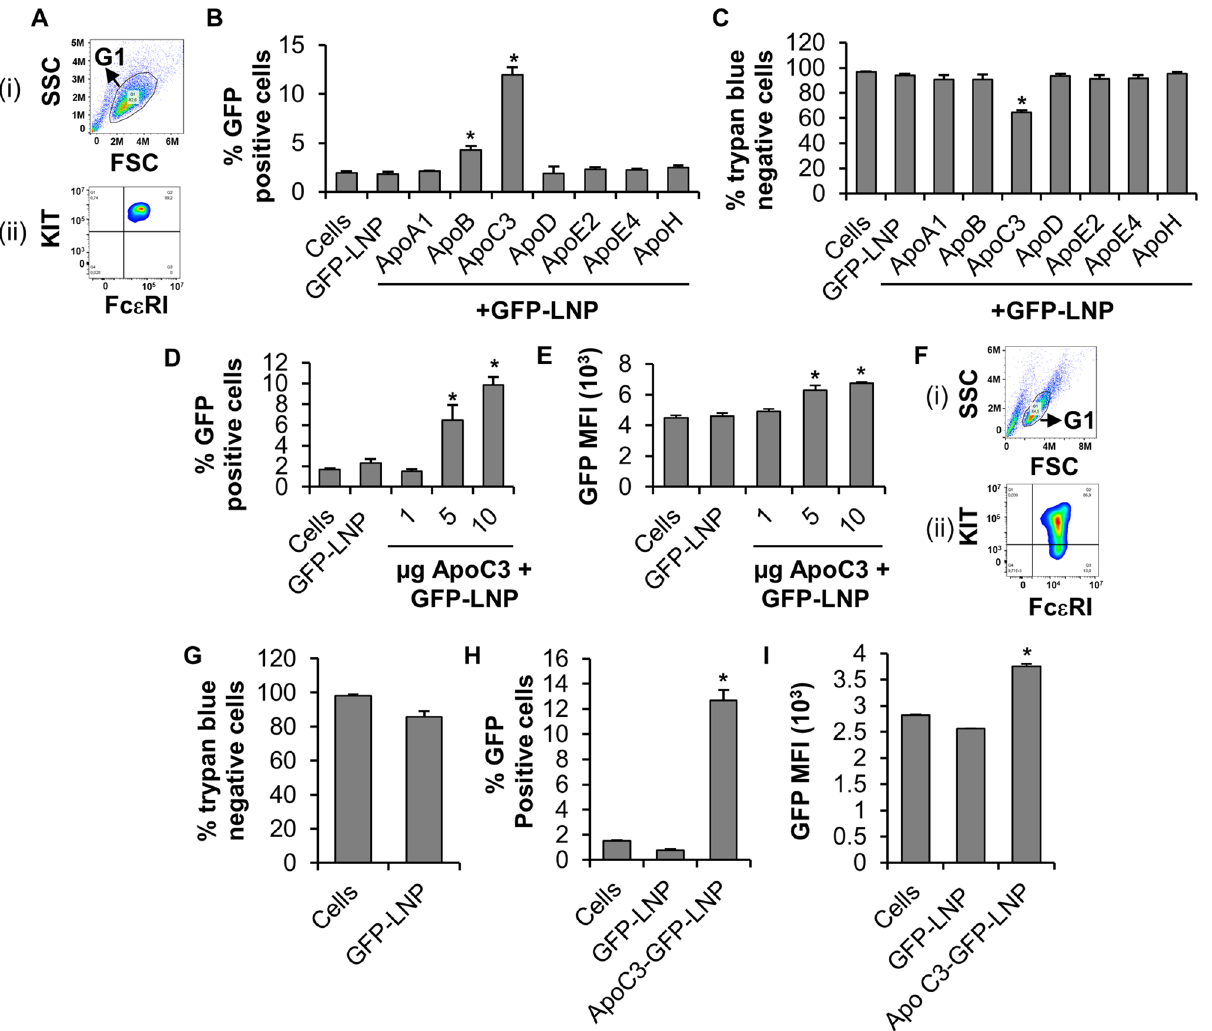
Figure 2. ApoC3 facilitates internalization of GFP-DODMA-LNP (GFP-LNPs) into BMMC and MC/9. ( A ) Gating strategy used to exclude debris/dead cells from flow cytometric analysis of terminally differentiated BMMC co-expressing FcεRI and KIT receptors. ( B , C ) BMMC were treated with 3 µg Apo (ApoA1, B, C3, D, E2, E4 and H)-GFP-LNP’s or GFP-LNP alone followed by flow cytometry ( B ) or trypan blue staining ( C ). Cells represent control BMMC that have not been treated with GFP-LNP or Apo-GFP-LNP. ( D , E ) BMMC were transfected for 24 h with ApoC3 (1–10 µg)-GFP-LNP’s followed by flow cytometry to determine % GFP positive cells ( D ) and GFP mean fluorescence intensity (MFI) ( E ). ( F ) Gating strategy used to exclude debris/dead cells from flow cytometric analysis of MC/9 co-expressing FcεRI and KIT receptors. ( G ) MC/9 were treated with GFP-LNP for 24 h followed by trypan blue staining. Cells represent control MC/9 that have not been treated with GFP-LNP. ( H , I ) MC/9 were transfected with 3 µg ApoC3-GFP-LNP followed by flow cytometry to determine % GFP positive cells ( H ) and GFP MFI ( I ). Cells represent control MC/9 that have not been treated with GFP-LNP or ApoC3-GFP-LNP. n = 3. p < 0.01 (*) is relative to positive cells with 5 and 10 µg of ApoC3 (Fig. 2D, p < 0.05; Supplementary Fig. 1A) and a concentration-depend- ent increase in GFP mean fluorescence intensity (MFI) (Fig. 2E). Apolipoprotein C3 facilitates internalization of GFP‑DODMA‑LNP into MC/9.. Since BMMC are considered to be an end-stage terminally differentiated myeloid-derived immune cells, we tested the internaliza- tion efficiency of GFP-DODMA-LNPs into a rapidly-dividing transformed mouse mast cell line called MC/9. MC/9 are similar to BMMC in that they express FcεRI (Fig. 2F-ii). When MC/9 cells were incubated with GFP- DODMA-LNPs for 24 h, a 14% reduction in cell viability was observed (Fig. 2G). MC/9 cells were treated with GFP-DODMA-LNP or ApoC3-GFP-DODMA-LNPs for 24 h and the GFP expression was measured by flow cytometry. For analysis purpose, healthy and unaltered cell population having high FSC and SSC (gated cells, G1; Fig. 2F-i) were considered to preclude the fluorescence emitted by dead cells/debris. ApoC3 significantly enhanced transfection efficiency of GFP-DODMA-LNPs into MC/9 to about 12.6 ± 0.8% when compared to cells